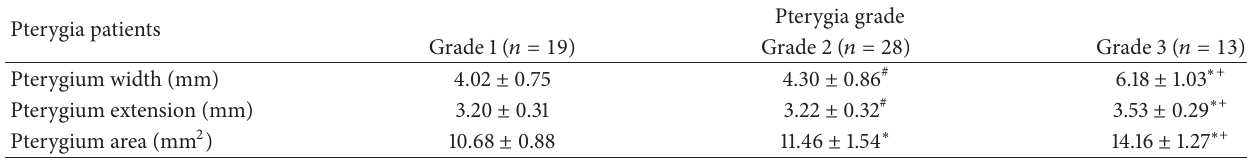
Table 1: Composition of recurrent